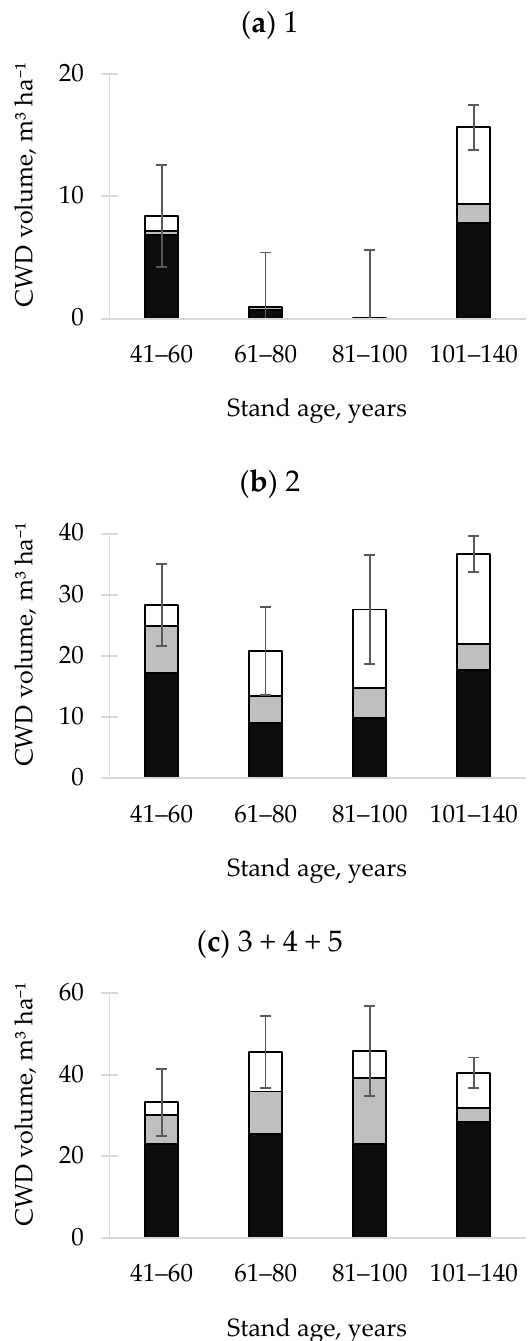
Figure 5. The marginal mean volume ( ± standard error) of coarse woody debris (CWD) in mature (41–60 years; n = 30), moderately overmature (61–80 years; n = 26), overmature (81–100 years; n = 17), and old-growth (101–140 years; n = 150) unmanaged European aspen ( Populus tremula L.) stands by adjusted decay classes: (1) recently dead, (2) weakly decayed, and (3 + 4 + 5) moderately to almost completely decomposed.